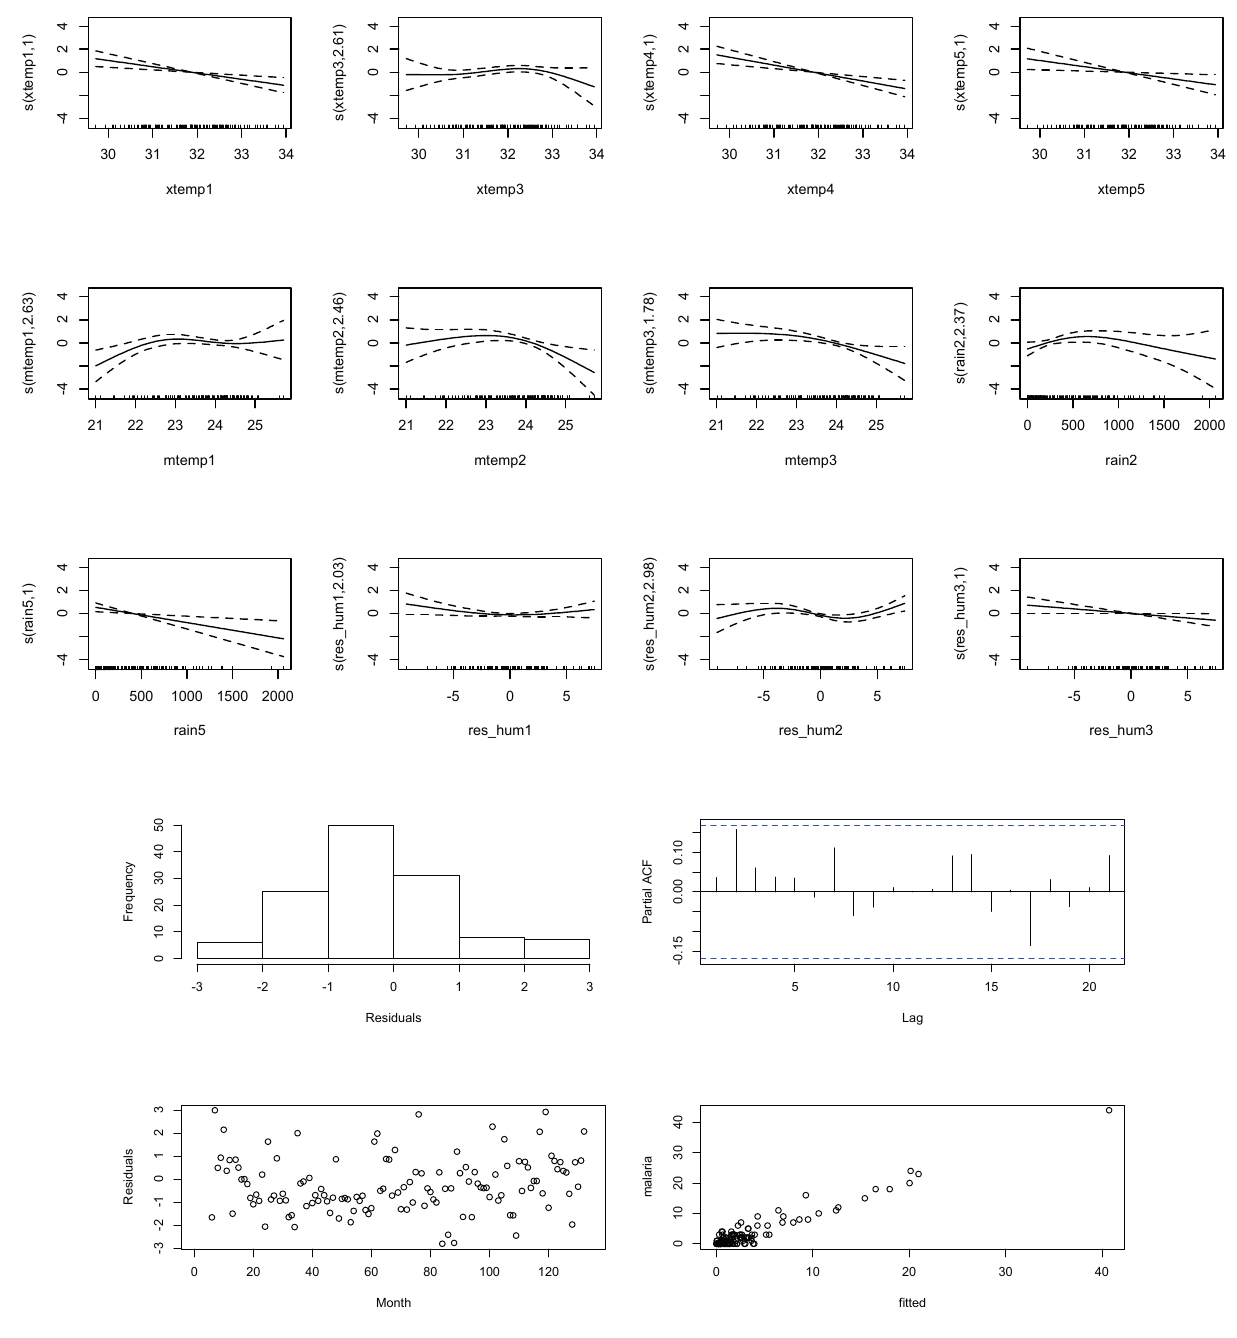
Figure 5. Relative risk of malaria cases as functions of respective climate variables at various lag